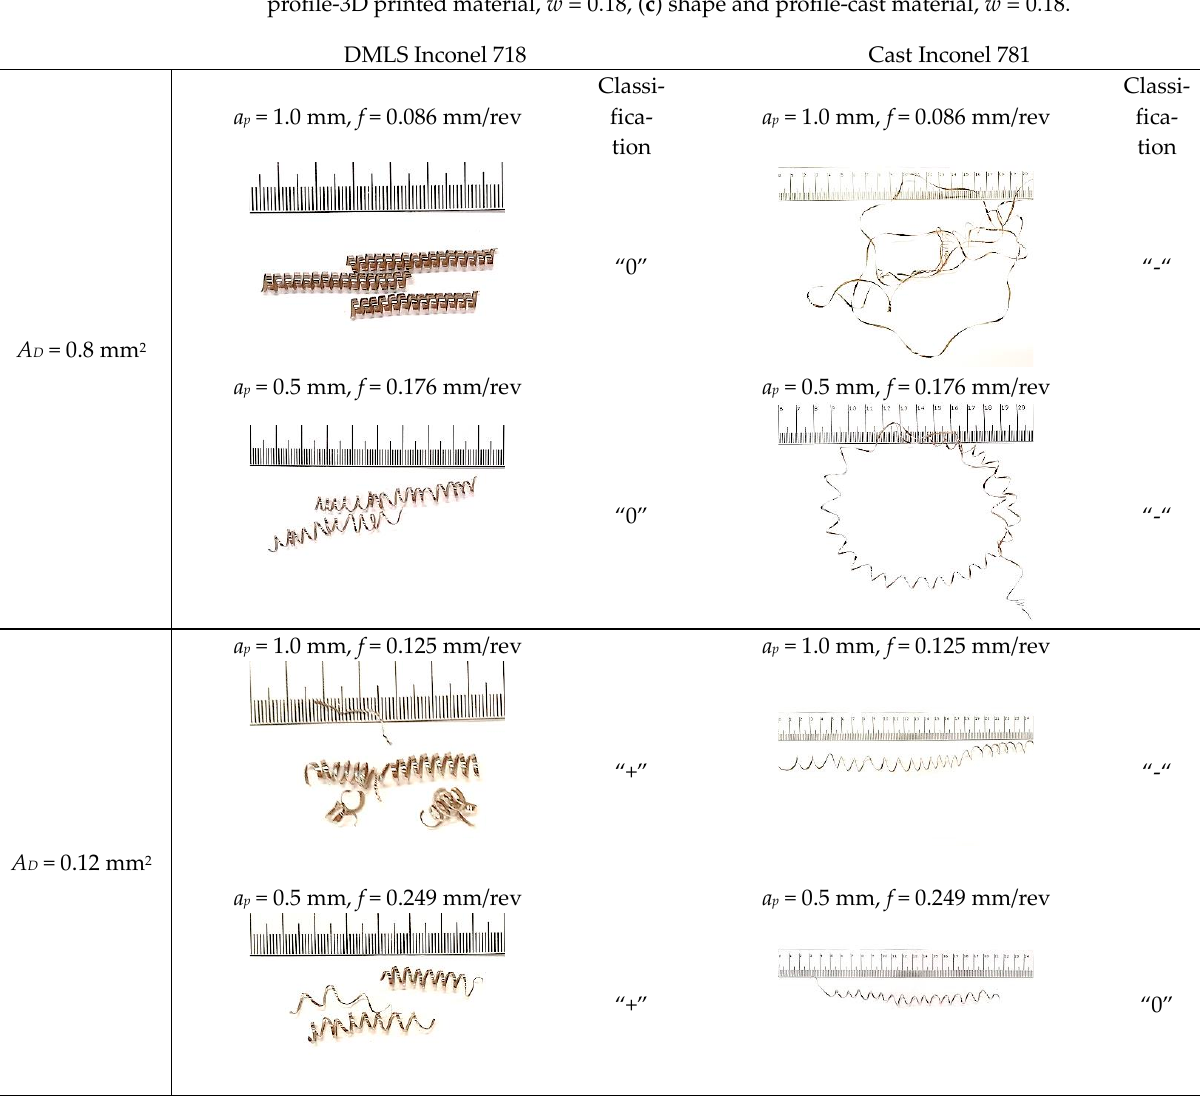
Figure 8. Chips’ photographs obtained for laser sintered and cast alloy turning.